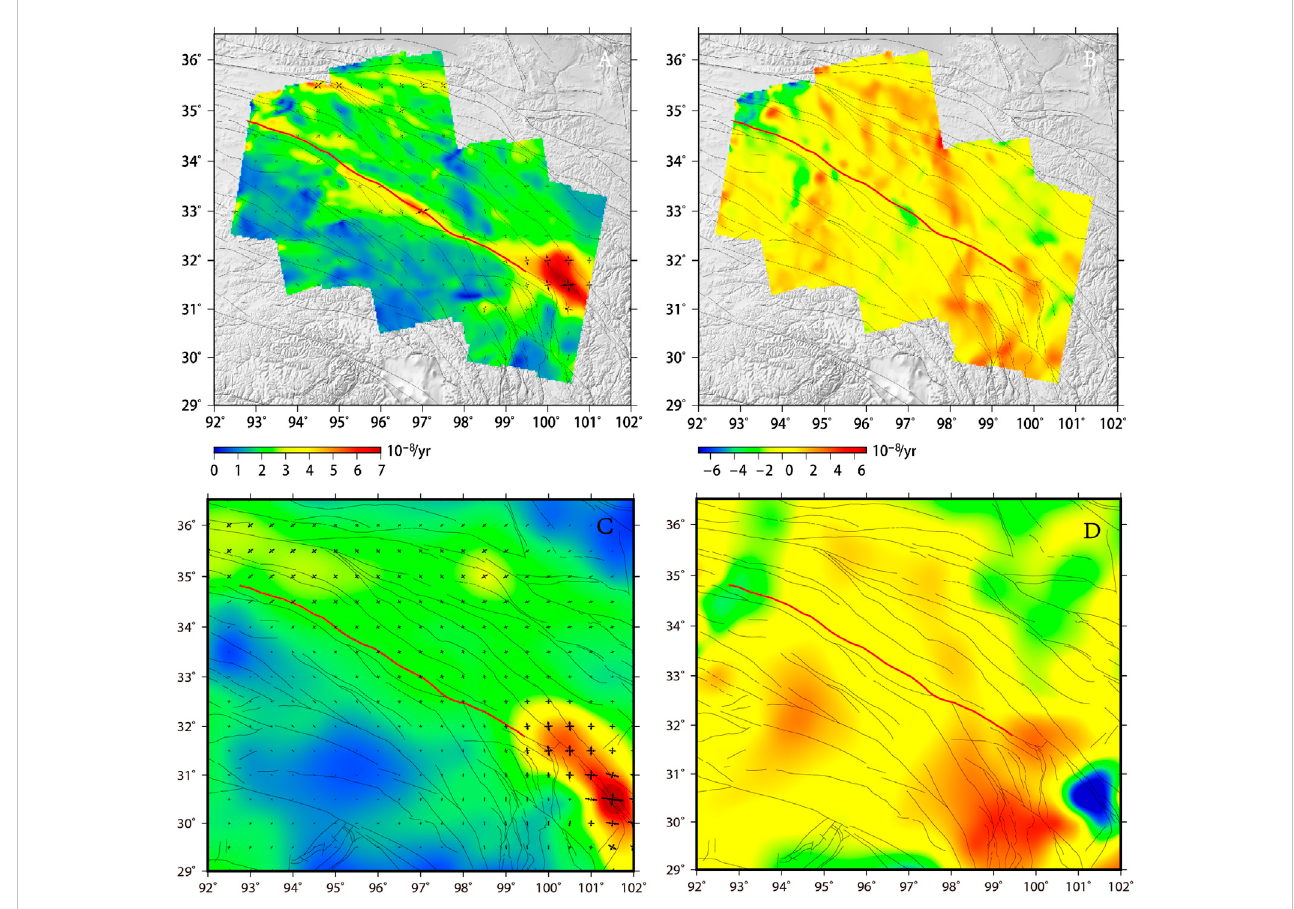
Strain rate fi elds around the Ganzi-Yushu fault zone: (A) integrated InSAR-GNSS maximum shear strain rate/principal strain rate fi eld, (B) integrated InSAR-GNSS surface strain rate fi eld, (C) GNSS maximum shear strain rate/principal strain rate fi eld, and (D) GNSS surface strain rate fi